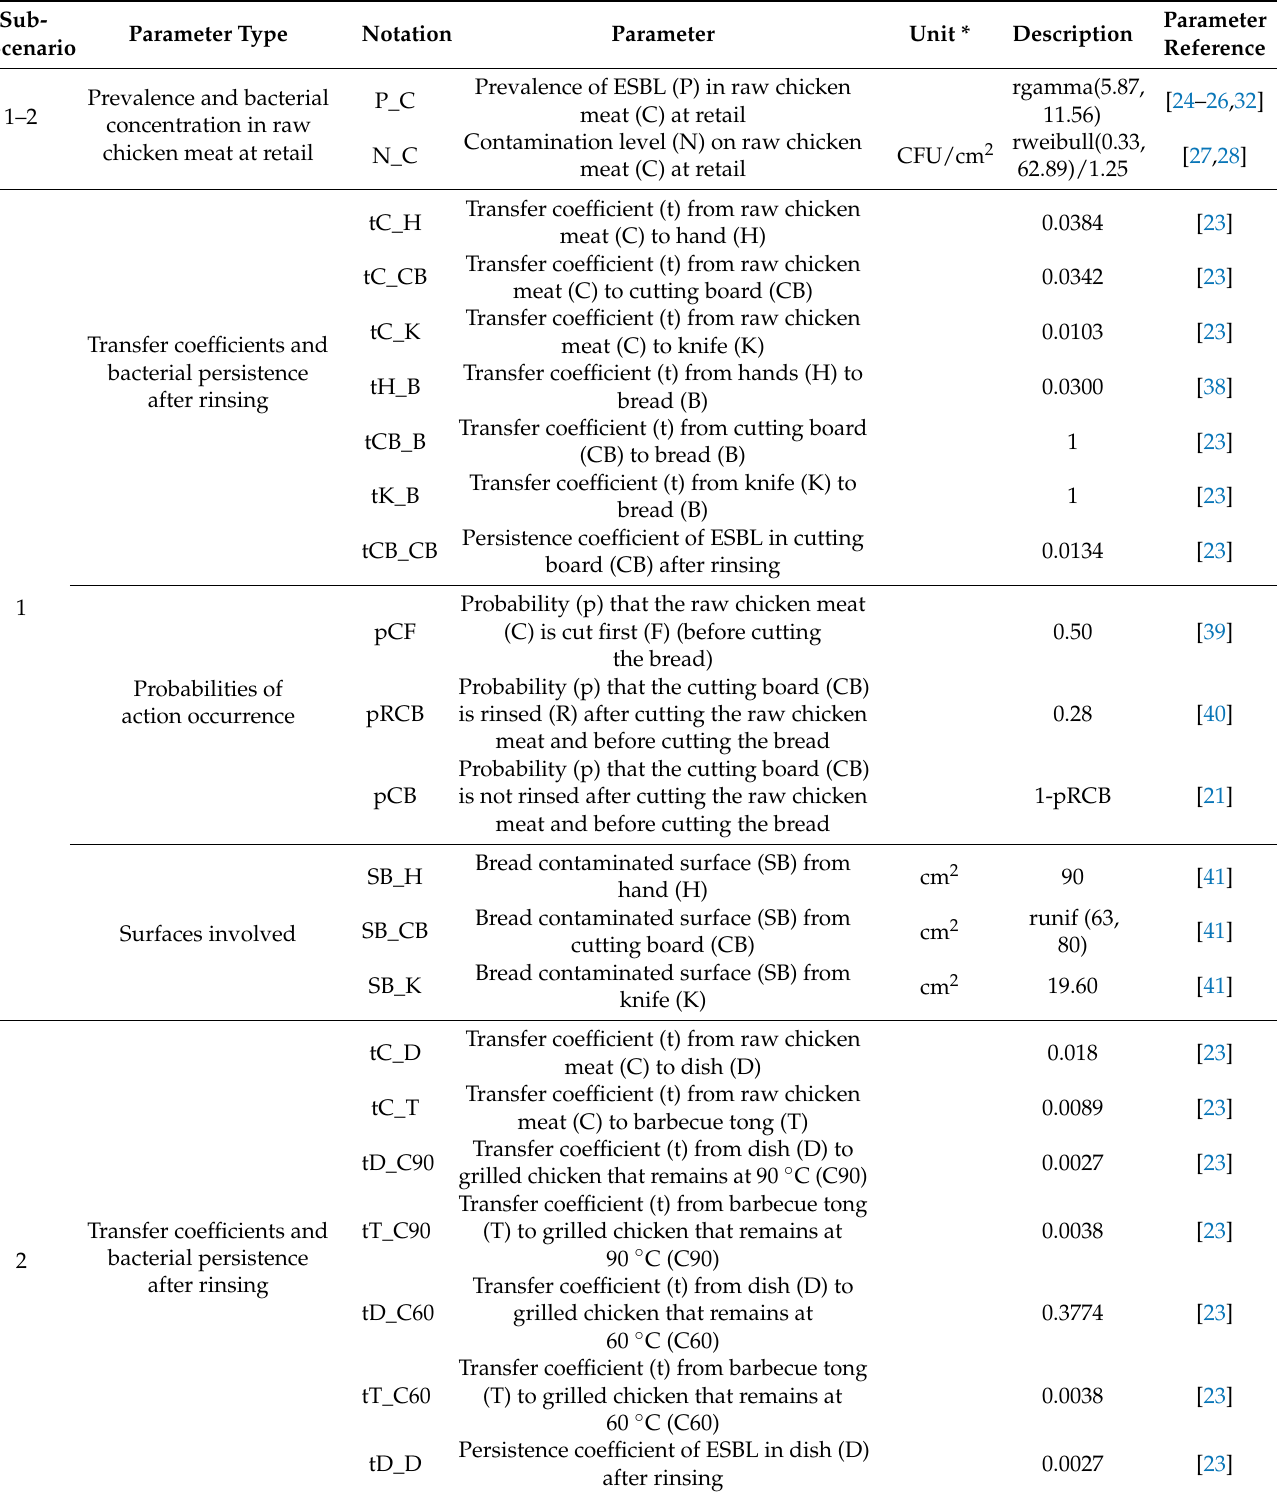
Table 1. Detailed description of the model parameters including definitions, default numerical values and sources of information (ESBL = ESBL-/AmpC-producing E. coli